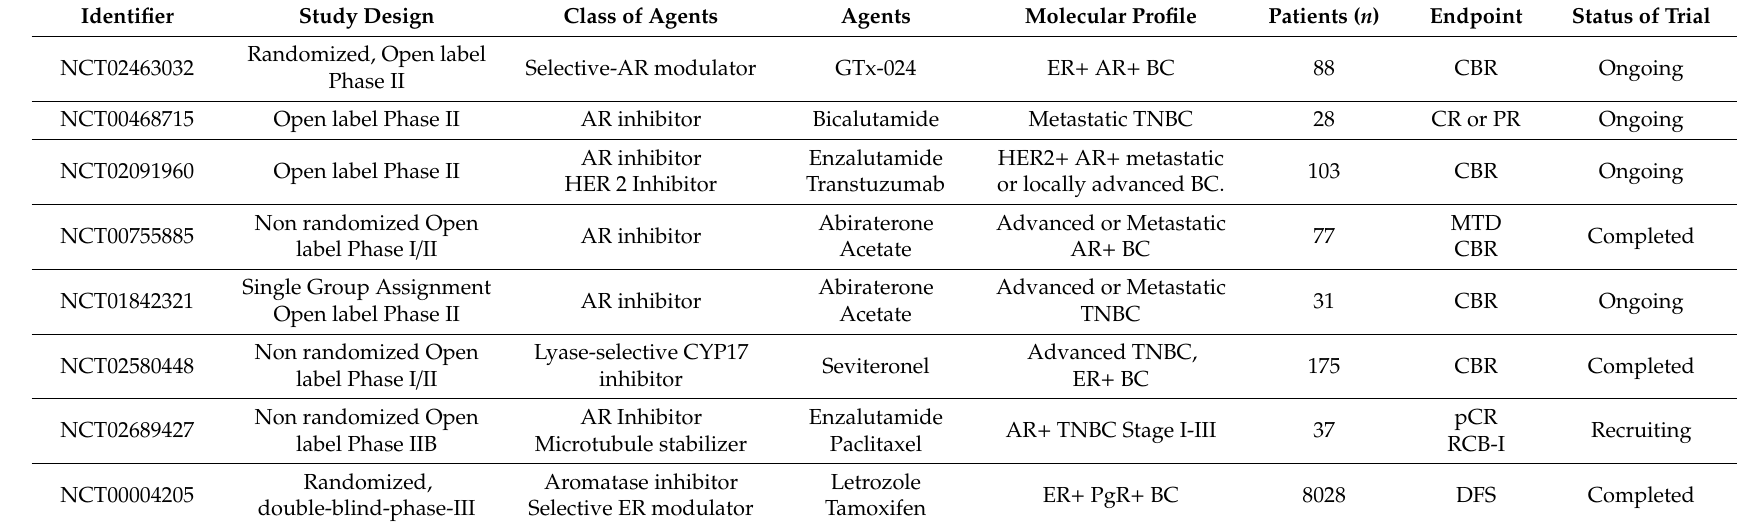
Table 1. Androgen blockade-based clinical studies in breast